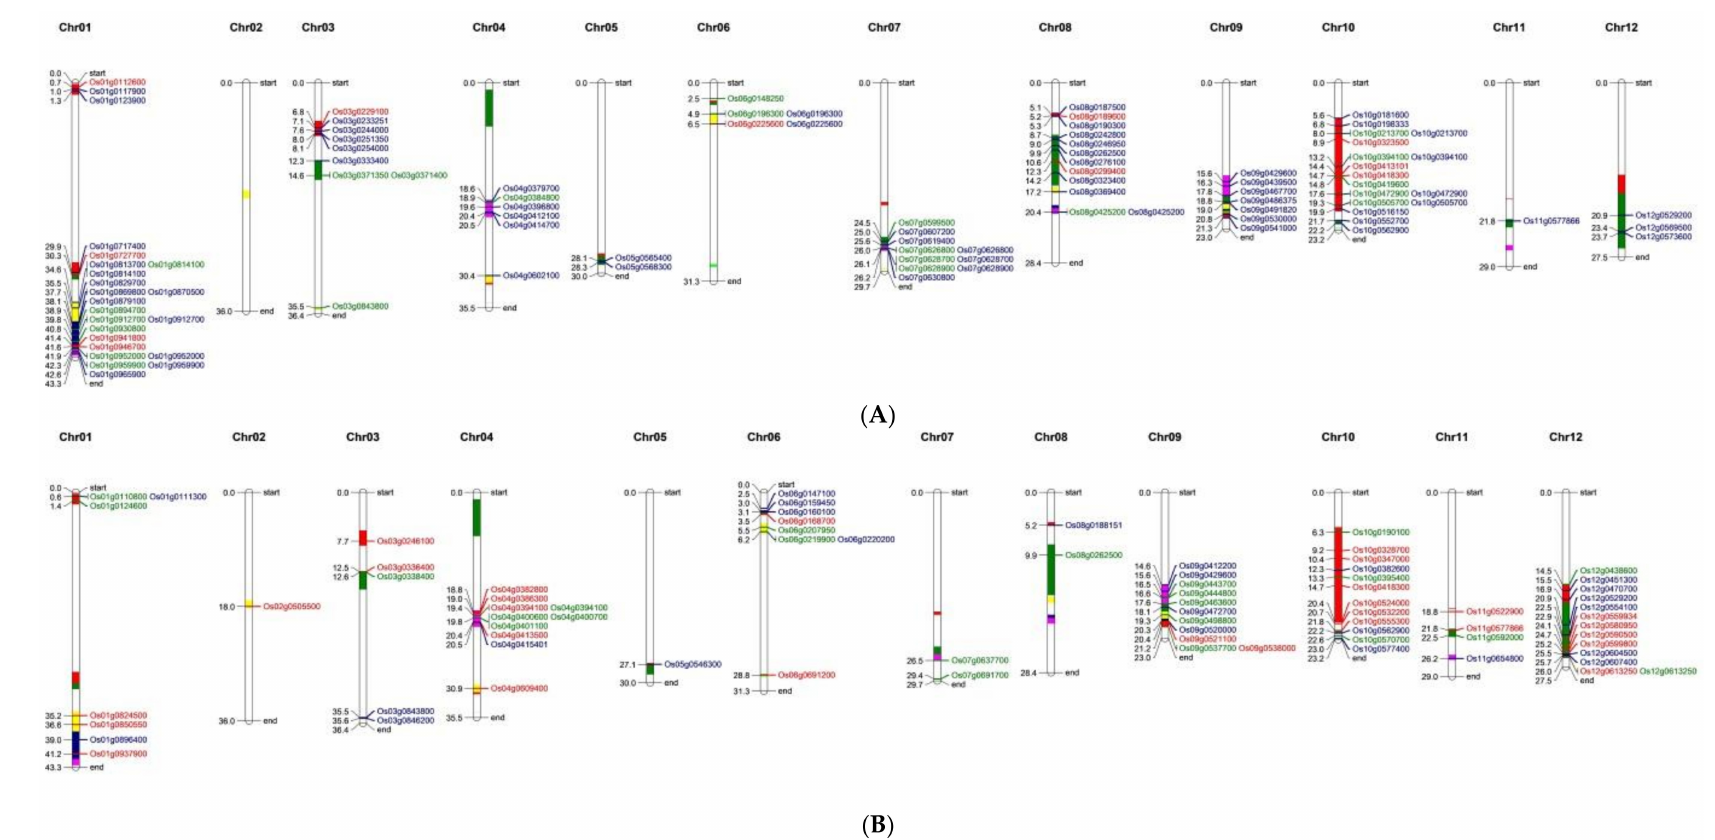
Figure 8. Map chart depiction of DEGs in root and shoot. DEGs identified under optimal (N+) and low N (N − ) from IR64, Nagina 22 and IR64 vs. N22 and co-localized with the QTL regions governing nitrogen use efficiency in rice specific to root tissues ( A ). DEGs identified under optimal (N+) and low N (N − ) from IR64, Nagina 22, and IR64 vs. N22 and co-localized with the QTL regions governing nitrogen use efficiency in rice specific to shoot tissues ( B ). Red represents genes differentially expressed in IR64 under low N, while green represents those from N22 with respective optimal N treatment as control. The genes differentially expressed between the two genotypes are shown in